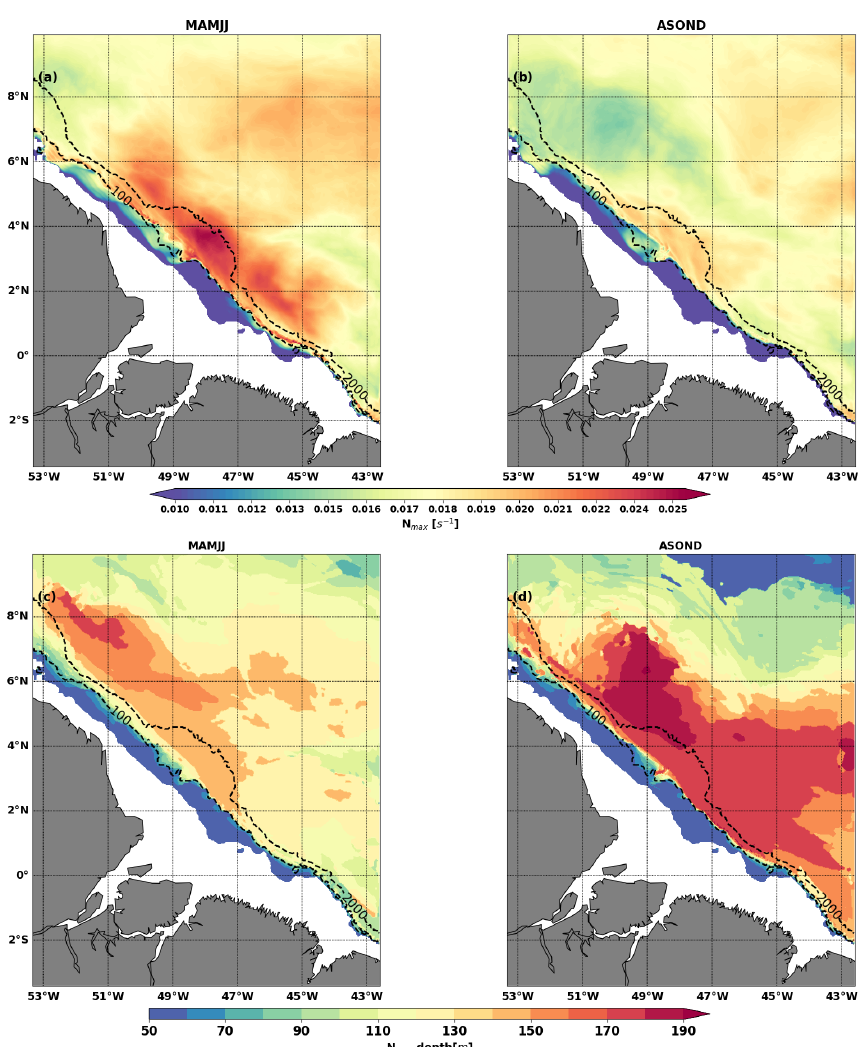
Figure 5. (a, b) N max value (units: s − 1 ) during MAMJJ (a) and (b) ASOND. (c, d) Pycnocline depth (depth of N max , units: m) during MAMJJ (c) and (d) ASOND. The N max value and depth were deducted from the mean potential density over each season. Dashed black contours are 100 and 2000m isobaths. Bathymetry less than 50m is masked. Table 1. Circulation and stratification characteristics during the MAMJJ and ASOND seasons.